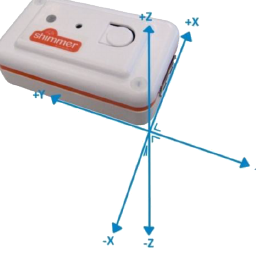
Figure 2. Shimmer TM accelerometer sensor and its coordinates